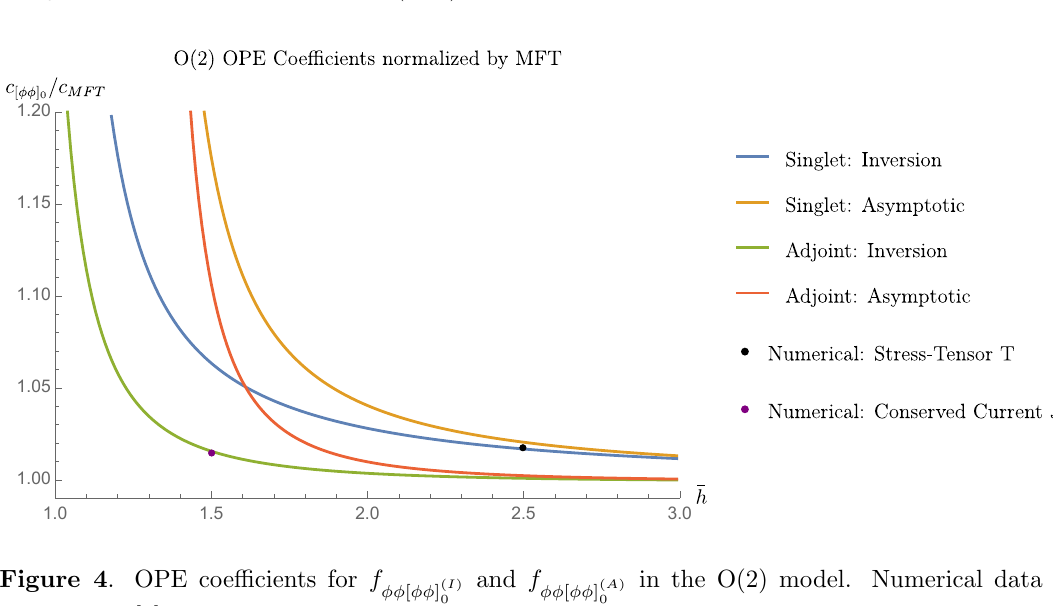
Table 2 . We list results for the twists and OPE coefficients for the double-twist family [ φφ ] 3d O(2) model by either matching at z = . 1 or using the na¨ıve log z matching valid for perturbative anomalous dimensions. The errors are approximate and come from both numerical input and from using the lower and upper values in (2.52).